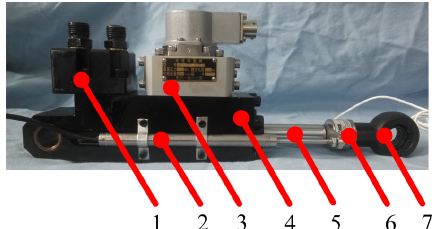
Figure 13. A four-legged robot with an electrohydraulic servo ac- tuator. (1) Valve assembly. (2) Displacement vector sensor element. (3) Servo control valve with asymmetry. (4) Electrohydraulic servo execution cylinder. (5) Location marking device. (6) Force vector sensor element. (7) Articulated bearing with full-space rotation per-